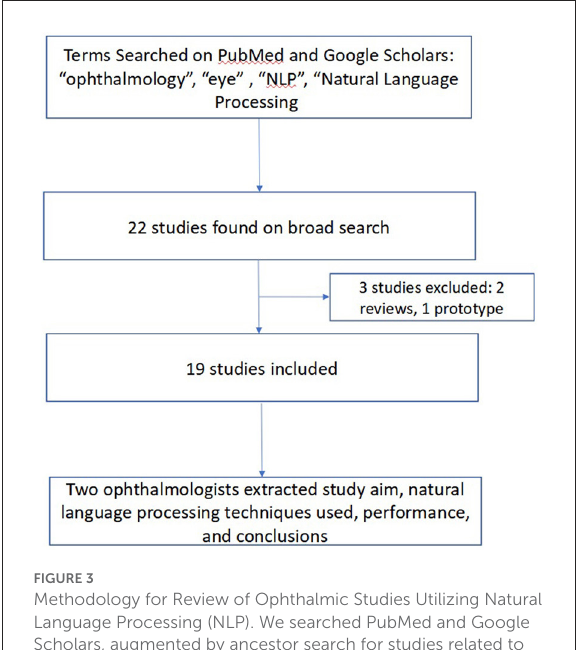
FIGURE3 Methodology for Review of Ophthalmic Studies Utilizing Natural Language Processing (NLP). We searched PubMed and Google Scholars, augmented by ancestor search for studies related to use of NLP in ophthalmology